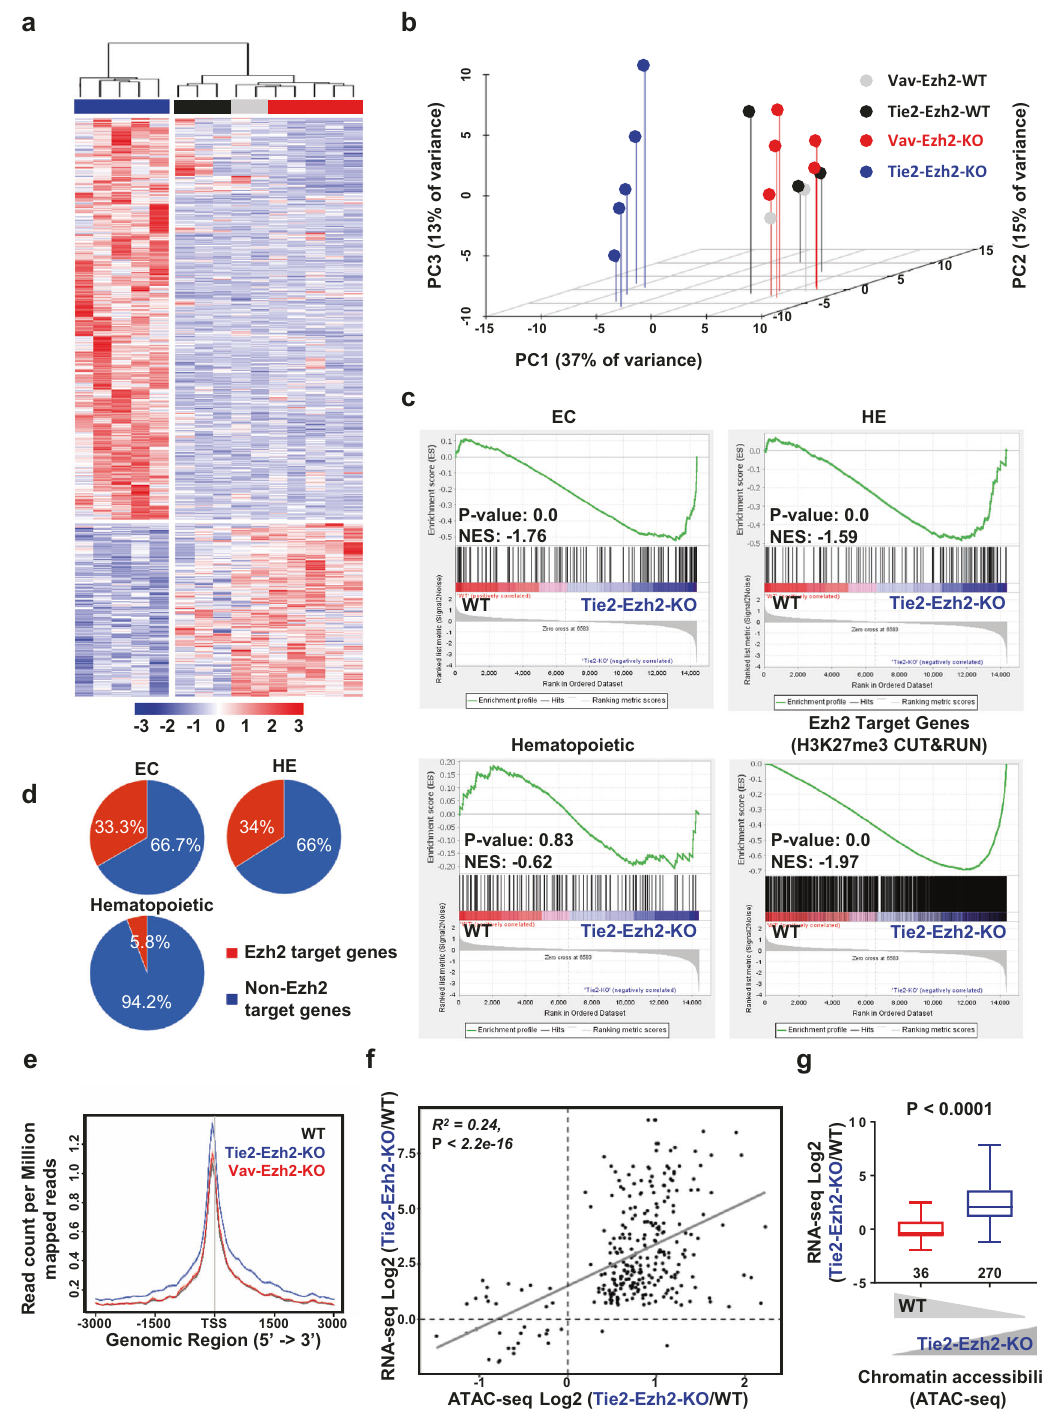
Fig. 2 Tie2-Ezh2-KO EMPs maintain endothelial and HE gene expression signatures. a Hierarchical clustering and heatmap showing expression levels of all signi fi cantly DE genes between Vav-Ezh2-WT ( n = 2), Tie2-Ezh2-WT ( n = 3), Vav-Ezh2-KO ( n = 5) and Tie2-Ezh2-KO ( n = 5) EMPs. Each replicate represents 100 puri fi ed EMPs from individual YS at E10.5 (3 independent experiments). b Principal component analysis of RNA-seq data in a . c GSEA comparing WT and Tie2-Ezh2-KO EMP for EC, HE, hematopoietic and Ezh2 target gene sets. d Proportion of Ezh2 target genes in EC, HE and hematopoietic gene sets. e Enrichment of ATAC-seq signal around transcription start site (TSS) in E10.5 YS EMPs. Vav-Ezh2-WT ( n = 3), Tie2-Ezh2-WT ( n = 3), Vav-Ezh2-KO ( n = 3) and Tie2-Ezh2-KO ( n = 5). Each replicate represents 500 puri fi ed EMPs from individual YS at E10.5 (2 independent experiments). f Scatterplot depicting a signi fi cant positive correlation between RNA-seq (selected DE genes, P < 0.05, RPKM > 0.2) and ATAC-seq ( P < 0.05) dataset. Statistical signi fi cance was determined based on the Pearson correlation coef fi cients. g Threshold-free comparison between differential accessibility ( ≤ or ≥ 1.5FC, P < 0.05) and RNA expression level. Medians are shown as a solid black line, box indicates the upper (75%) and lower (25%) percentile, whiskers indicate min to max. The numbers of genes are indicated at the bottom of each column. Two-tailed t-test was used to assess statistical signi fi cance. DE, differentially expressed; NES, normalized enrichment